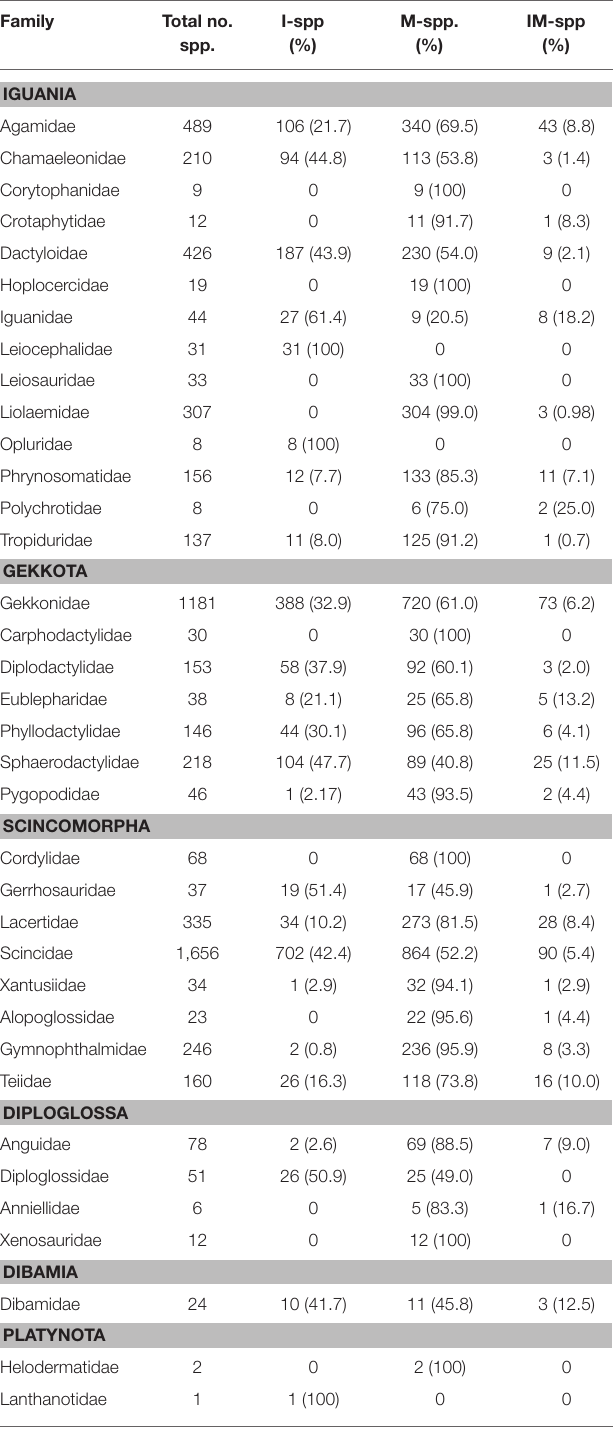
TABLE 1 | Number of lizard species (Sauria) in the families of the infraorders Iguania, Gekkota, Scincomorpha, Diploglossa, Dibamia, and Platynota, sorted according to their geographic distribution: I , island-only species; M , mainland-only species; and IM , species present on both island and mainland. Family